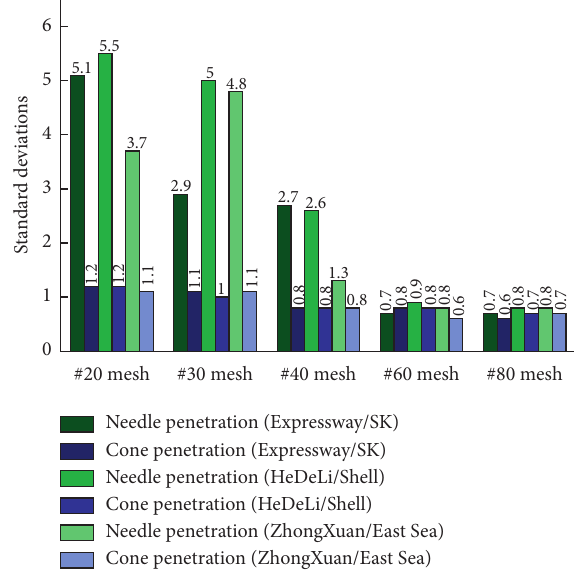
Figure 12: Standard deviations of the needle/cone penetration experimental results at 25 ° C for AR